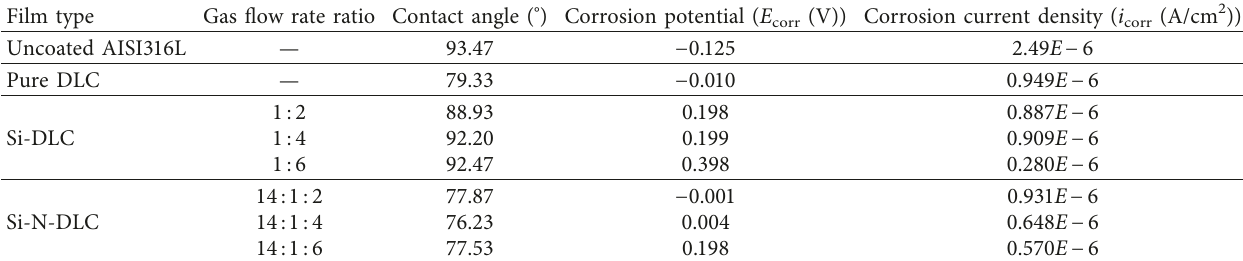
corr ), and corrosion current density ( i corr ) of pure DLC, Si-DLC, and Si-N-DLC films.